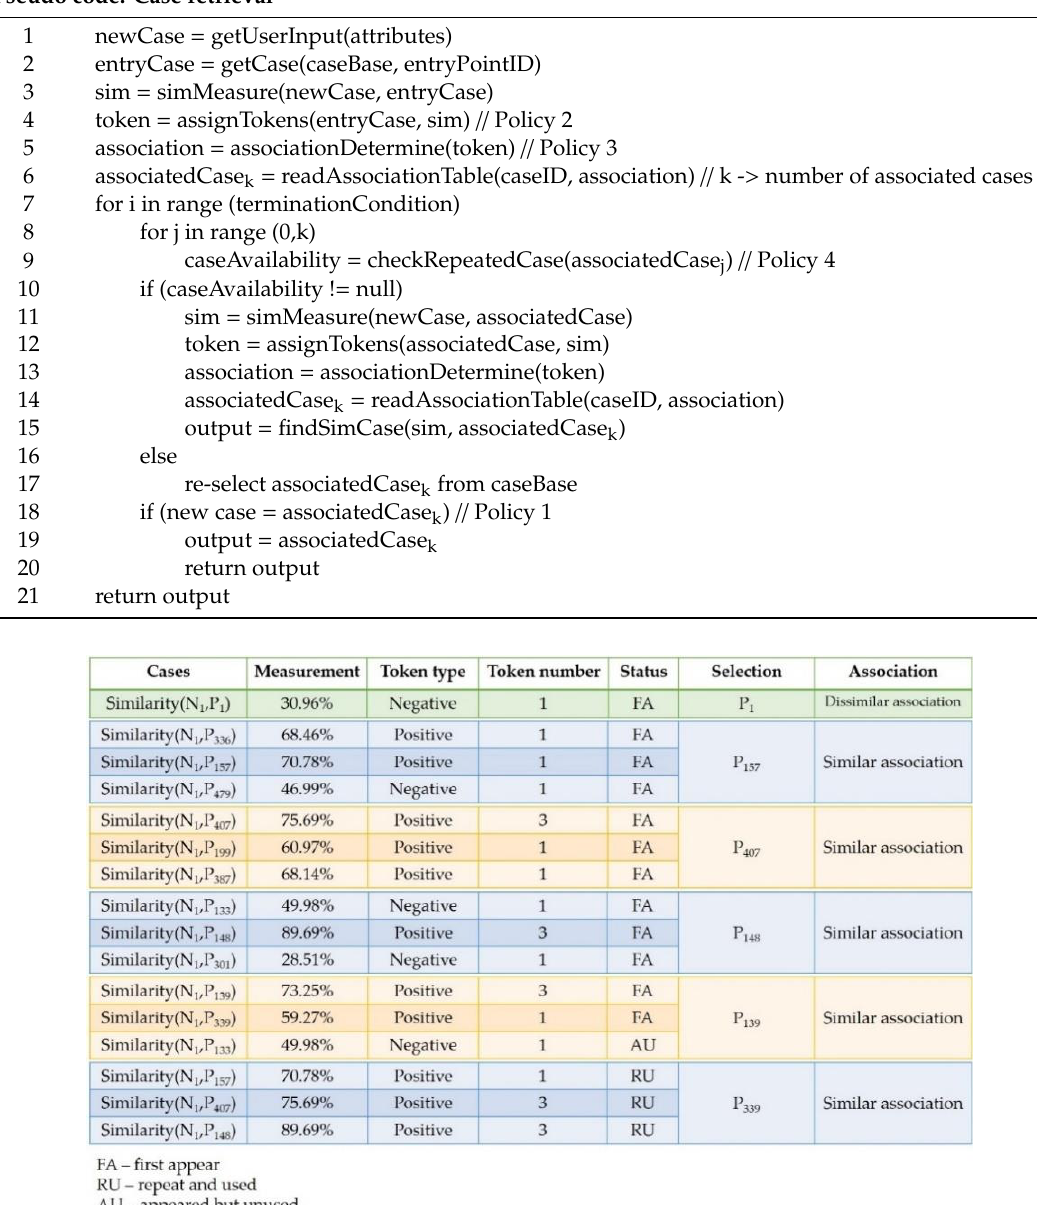
Table 5. The pseudo code of the proposed case retrieval algorithm.